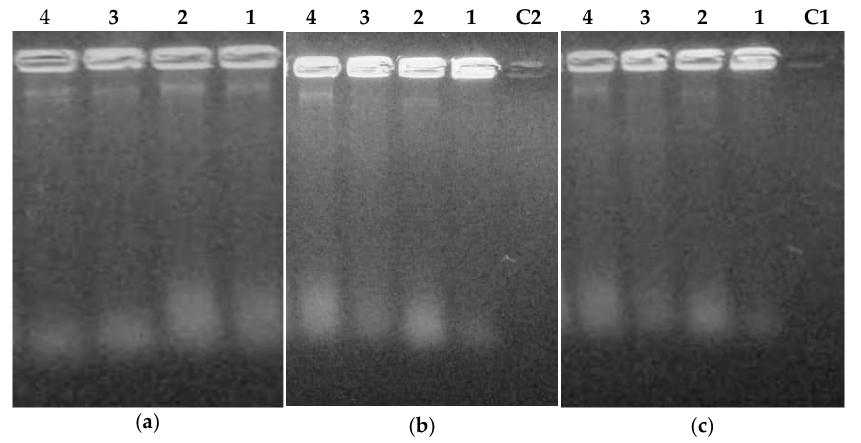
Figure 12. UV visualization of flavonoids treated S.aureus 60 lysates; ( a ) Chalcone 3 treatment, ( b ) Flavanone 8 treatment, ( c ) Flavone 10 treatment; 1 (1 × MIC) ( μ g/mL), 2 (2× MIC), 3 (3× MIC), 4 (4× MIC), C2 (Amp), C1 (Control).